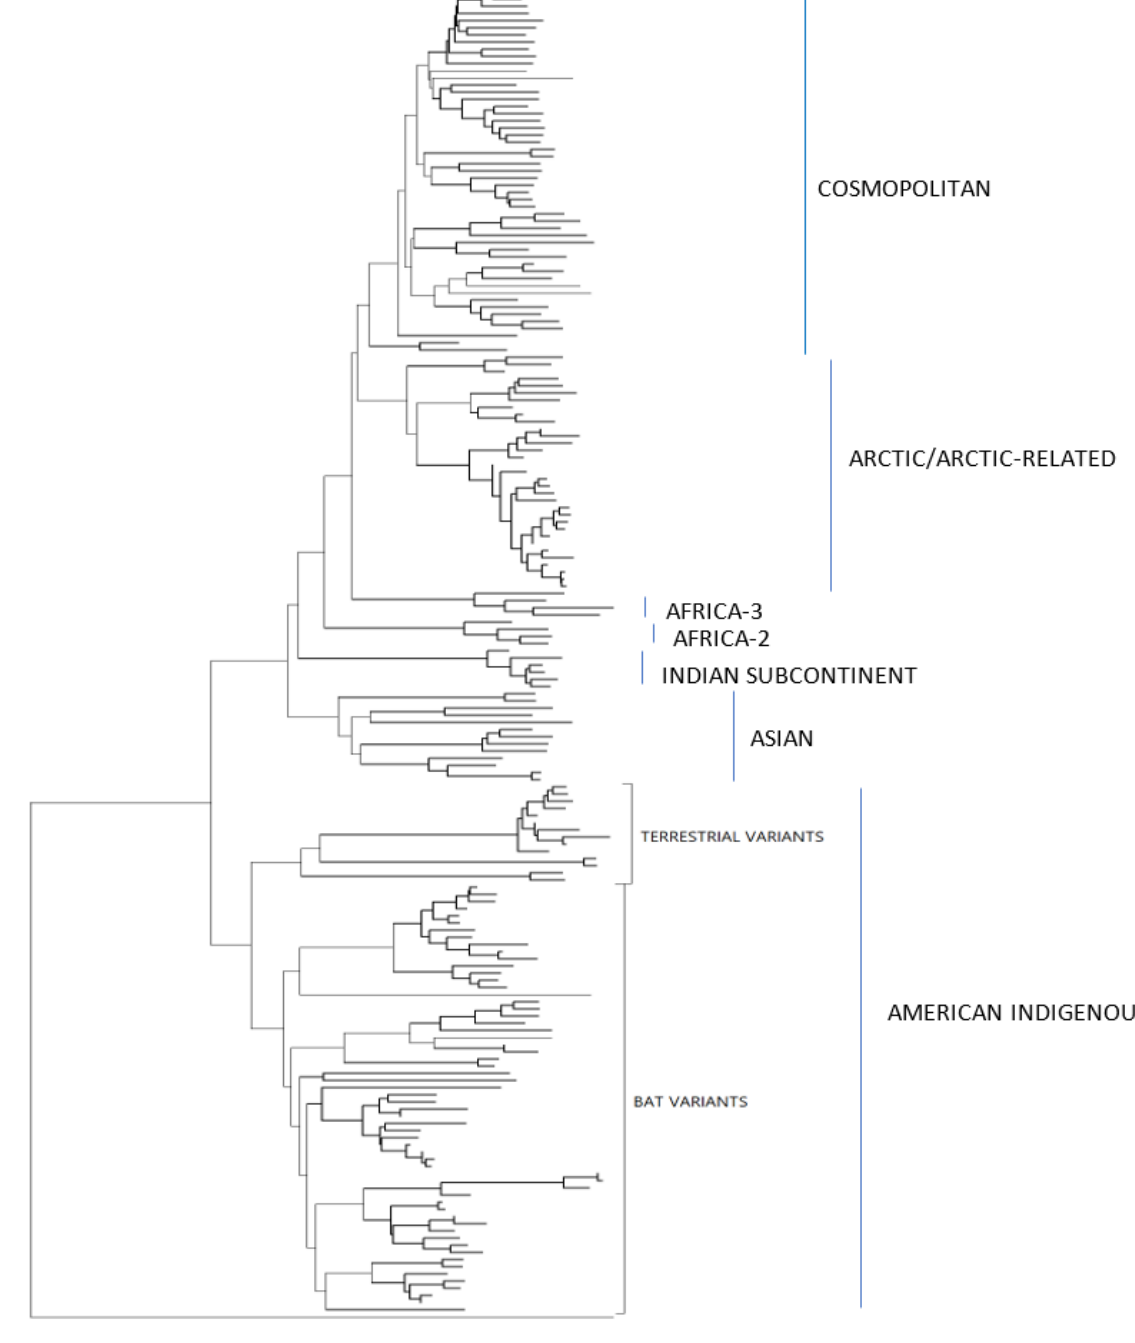
Figure 5. Neighbor joining tree of 86 RABV samples analyzed by the Ampliseq for Illumina protocol and 100 representative RABV genomes. Each sample genome was reconstructed through reference- guided assembly of the Ampliseq reads using one of eight reference sequences and a final alignment of 11,777 positions was generated. During the tree construction ambiguous positions and deletions were removed using a pairwise deletion option. An Australian bat lyssavirus (ABLV) sample was used as an outgroup. Lineages and variants are identified to the right of the tree.